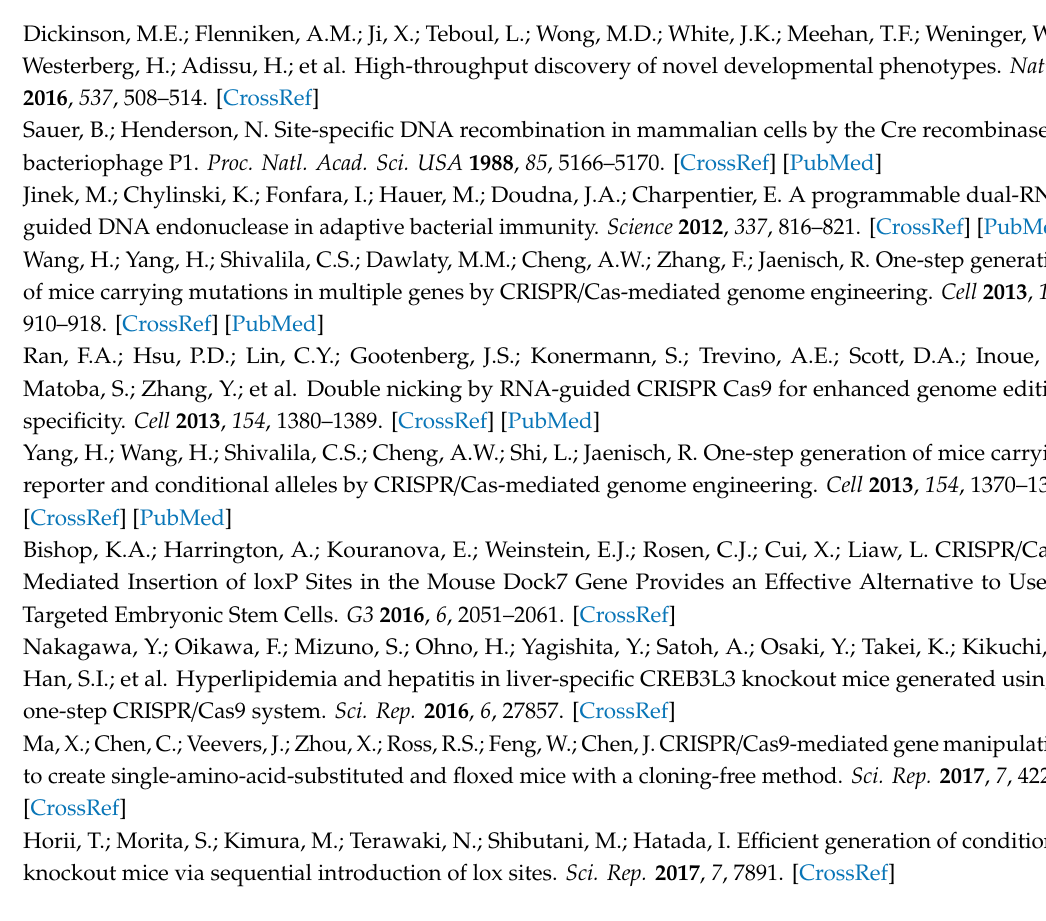
Figure S1: The morphology of embryos by hypertonic treatment. Figure S2: E ff ects of PBS( − ) treatment on blastomere fusion and embryonic development of 2-cell EP. Figure S3: The combined Ca 2 + -free and CB treatment does not have a better e ff ect on blastomere fusion than the only Ca 2 + -free